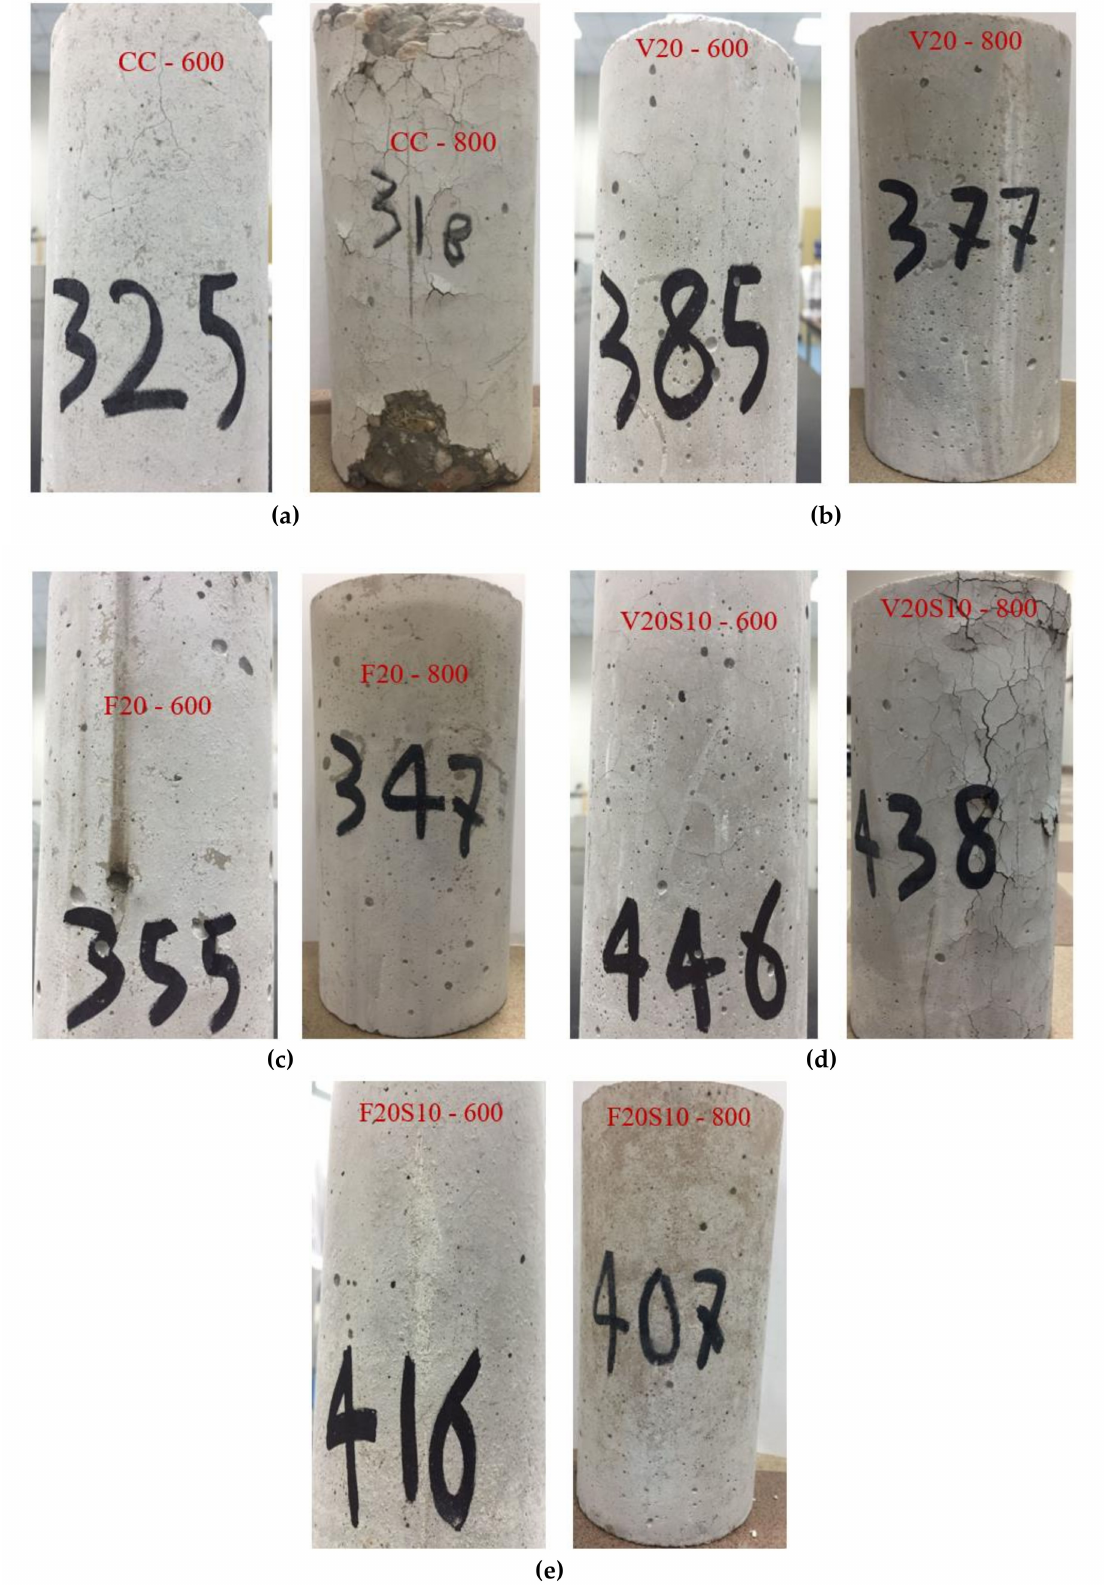
Figure 7. Comparison of surface cracks and spalling among some selected concrete specimens of all mixtures after exposure to 600 and 800 ◦ C: ( a ) CC, ( b ) V20, ( c ) F20, ( d ) V20S10, and ( e )